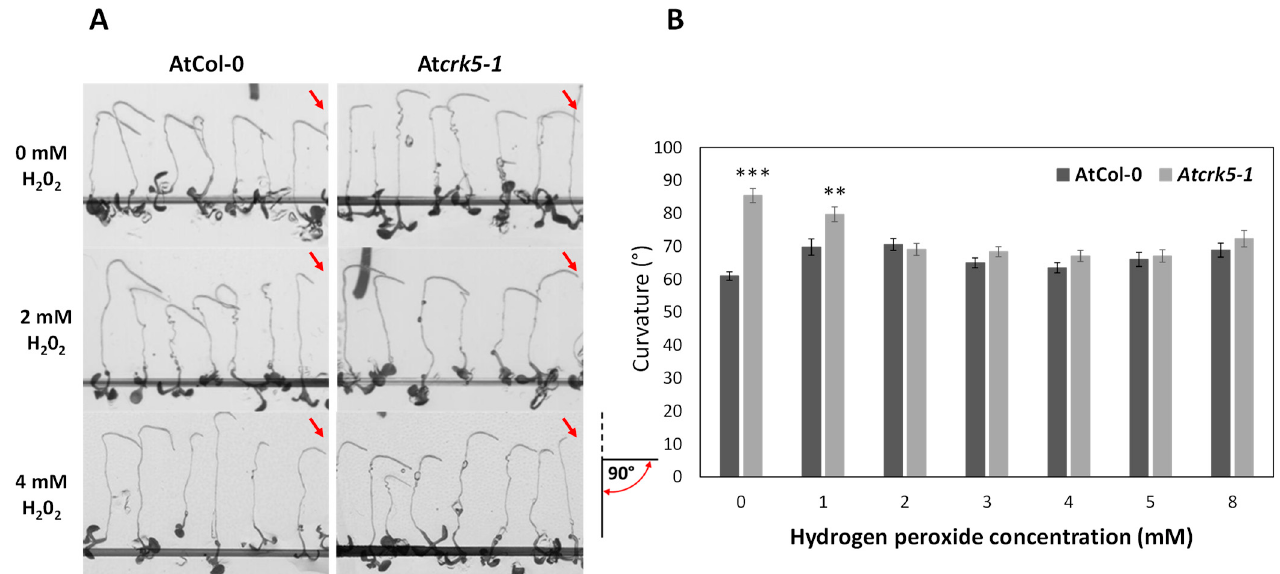
Figure 3. Effect of exogenous H 2 O 2 on root gravitropic response. ( A ) Seedlings were grown vertically for 5 days, then they were transferred to media containing different H 2 O 2 concentrations and immediately rotated by − 135° for 24 h. Red arrows indicate the direction of the gravity vector. The pictogram at the lower right corner shows the mode of the determination of the root curvature degree, the red semicircle with arrows indicates the measured angle. ( B ) Quantitative analysis of the H 2 O 2 effect on the degree of gravitropic curvatures of wild type (AtCol-0) and mutant (At crk5-1 ) roots. Asterisks indicate significant differences at ** p < 0.01 or *** p < 0.001 between the wild type (Col-0) and the mutant (At crk5-1 ). Measurements were performed with at least 30 seedlings per each line. Bars indicate standard error. At least three biologically independent experiments were carried out with the same statistical results.